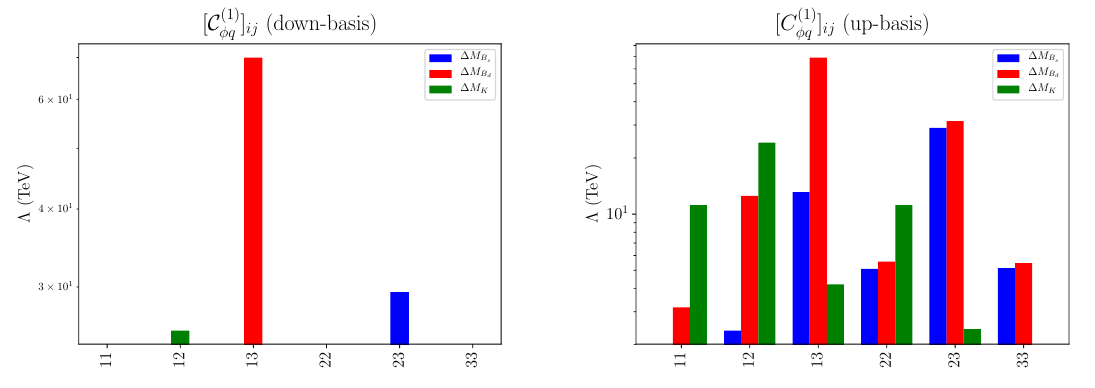
(cid:2) (cid:3) c (1) = 10 that corresponds to a 10% effect in φq ij